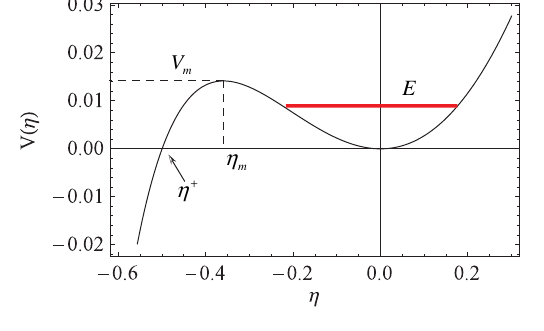
FIG. 13. Plot of V ð η Þ versus η obtained from Eq. (97) for 2 W 0 0 . 5 and η þ ¼ − 0 . 5 . Here, η u ¼ 0 . 014 . Nonlinear periodic solutions for η ð Z 0 Þ exist V ð η m Þ ¼ for energy level E in the range 0 < E < V ð η